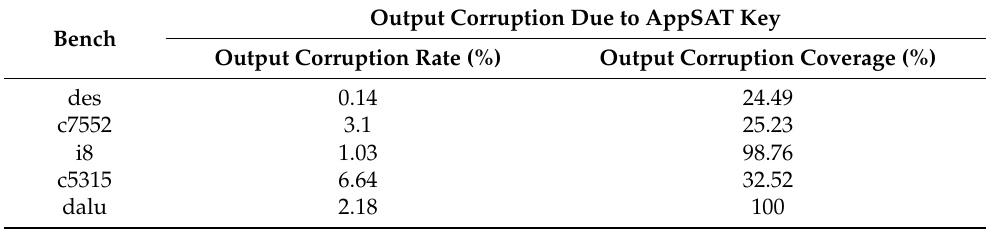
Table 2. AppSAT attack result on SKG-Lock+ ( n =